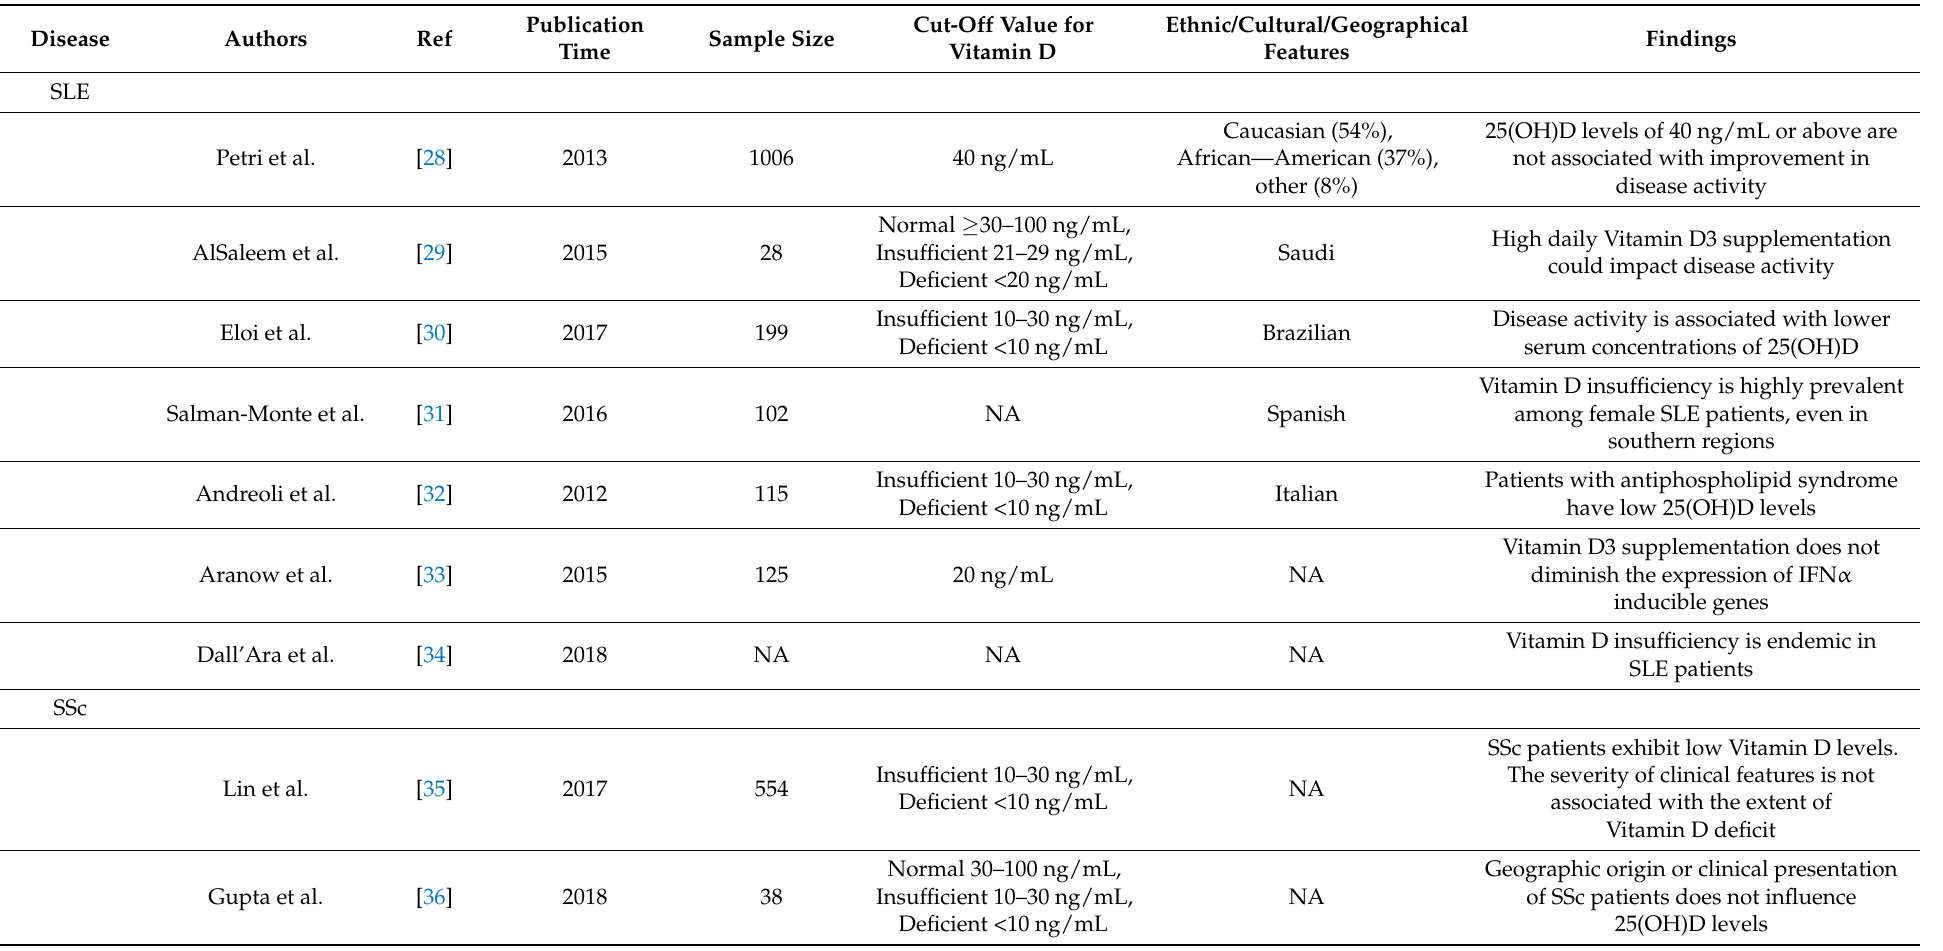
Table 1. Major findings from the observational studies evaluating Vitamin D serum levels in autoimmune